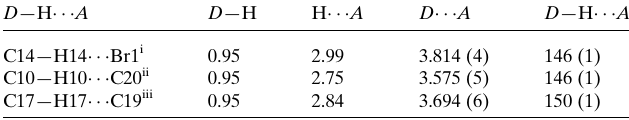
Table 2 Hydrogen-bond geometry (A˚ , (cid:3) ) for 3 .